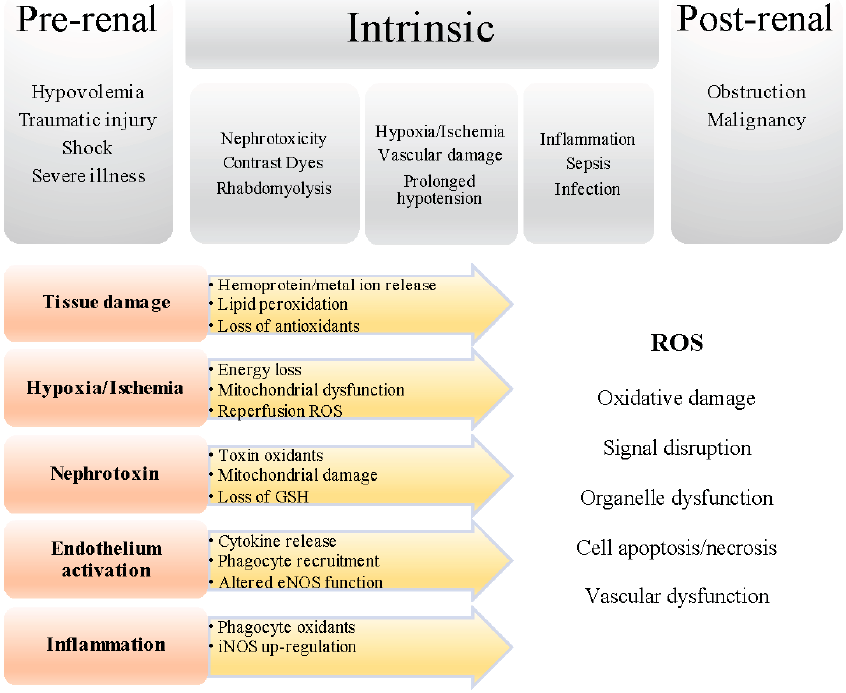
Figure 1. Increased reactive oxygen species (ROS) levels in acute kidney injury (AKI) induce renal oxidative damage and injury. Hypoxia and ischemia perturb microcirculation, cellular enzymes, and mitochondrial function, supporting production of intracellular ROS such as O 2 •− and H 2 O 2 , resulting in mitochondrial damage, depletion of ATP, and activation of cell death pathways. Reperfusion after ischemia also increases ROS. Ischemic injury activates endothelial cells up-regulating pro-inflammatory cytokines and recruiting phagocytes that contribute ROS via NOX and MPO. Inflammation induces ROS and iNOS, promoting peroxynitrite formation. Trauma and toxins generate oxidative stress by depleting endogenous antioxidants and increasing redox-active metal ions. Vascular dysfunction promoted by ischemia, inflammation, or toxicity, affects eNOS function, inducing ROS generation. ROS perturb kinase/phosphatase activities and transcription factor signaling pathways important in cell homeostasis. Oxidative modification of membranes and proteins disrupts cell ion and nutrient transport, energy metabolism, and organelle function, ultimately affecting kidney viability.